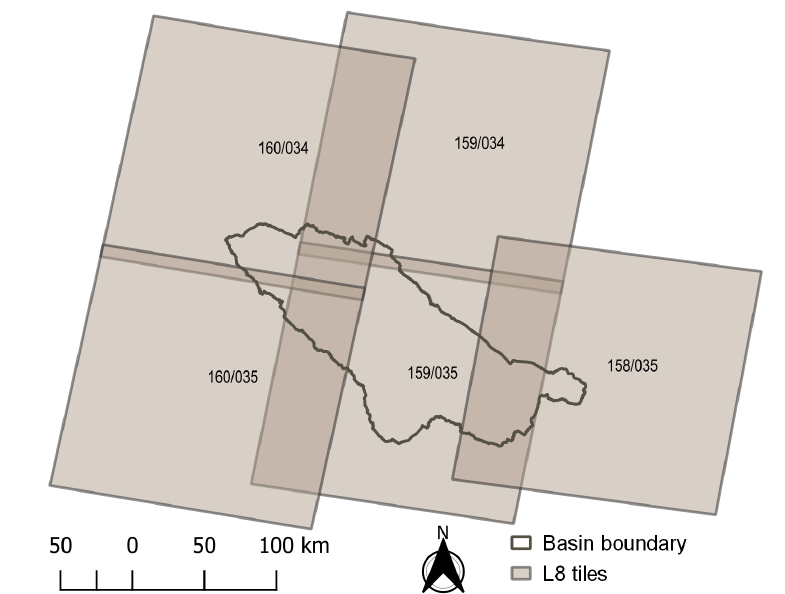
Figure 2. Five Landsat tiles covering the study area. The numbers indicate the path and row, for example 160/034 represents path 160 and row